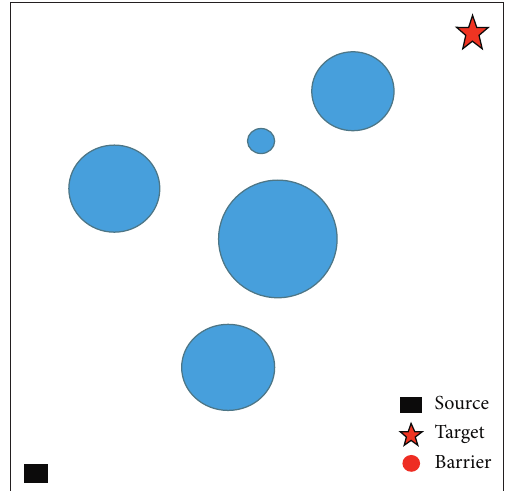
Figure 7: Robot workplace